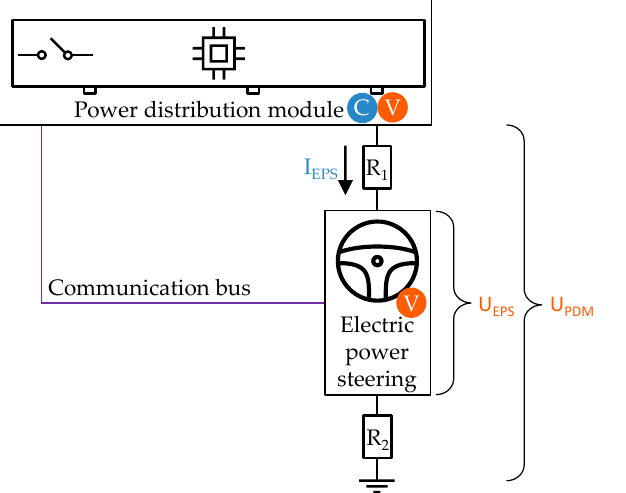
Figure 4. Measuring points of wiring harness diagnostics for determining the resistance between power distribution module, electric power steering and